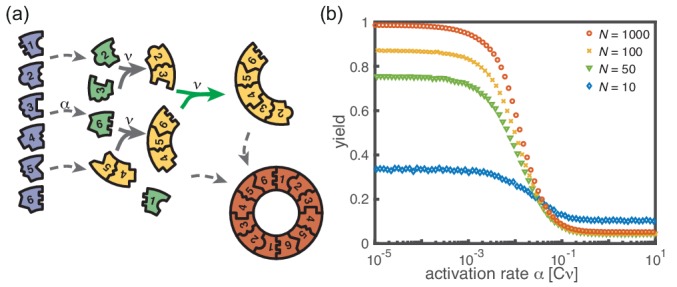
Extended model including polymer-polymer binding.(a) In the extended model, structures not only grow by monomer attachment but also by binding with another polymer (colored arrow). As before, binding only happens between periodically consecutive species with rate ν per binding site. So, the reaction rate for two polymers is identical to the one for monomer-polymer binding, ν. Furthermore, only polymers with combined length ≤L can bind. All other processes and rules are the same as in the original model described in Figure 1. (b) The yield of the extended model as obtained from stochastic simulations is shown in dependence of the activation rate α for S=L=100, μ=ν=1, Lnuc=2 and different values of the number of particles per species, N (averaged over 1024 ensembles). The qualitative behavior is the same as for the original model. In particular, yield saturates (in the stochastic limit) at an imperfect value for slow activation rates. Note that for small particle numbers polymer-polymer binding results in an increase of the minimal yield (here for large activation rates). This is due to the fact that even in the case where a priori too many nucleation events happen, polymers can combine into final structures.